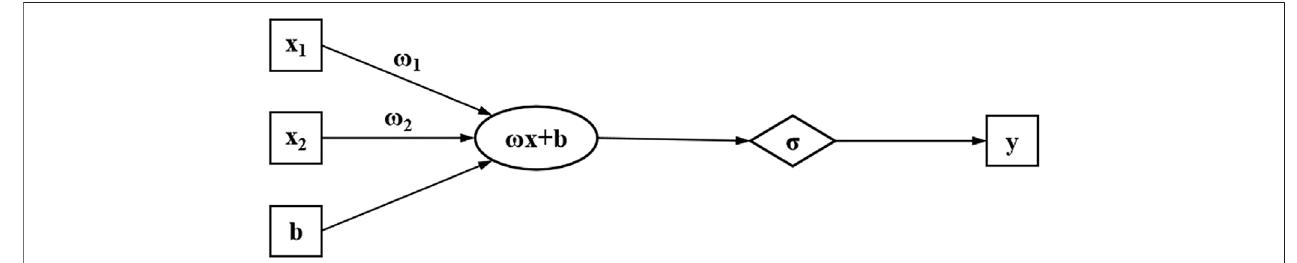
FIGURE 1 | Schematic diagram of activation function.